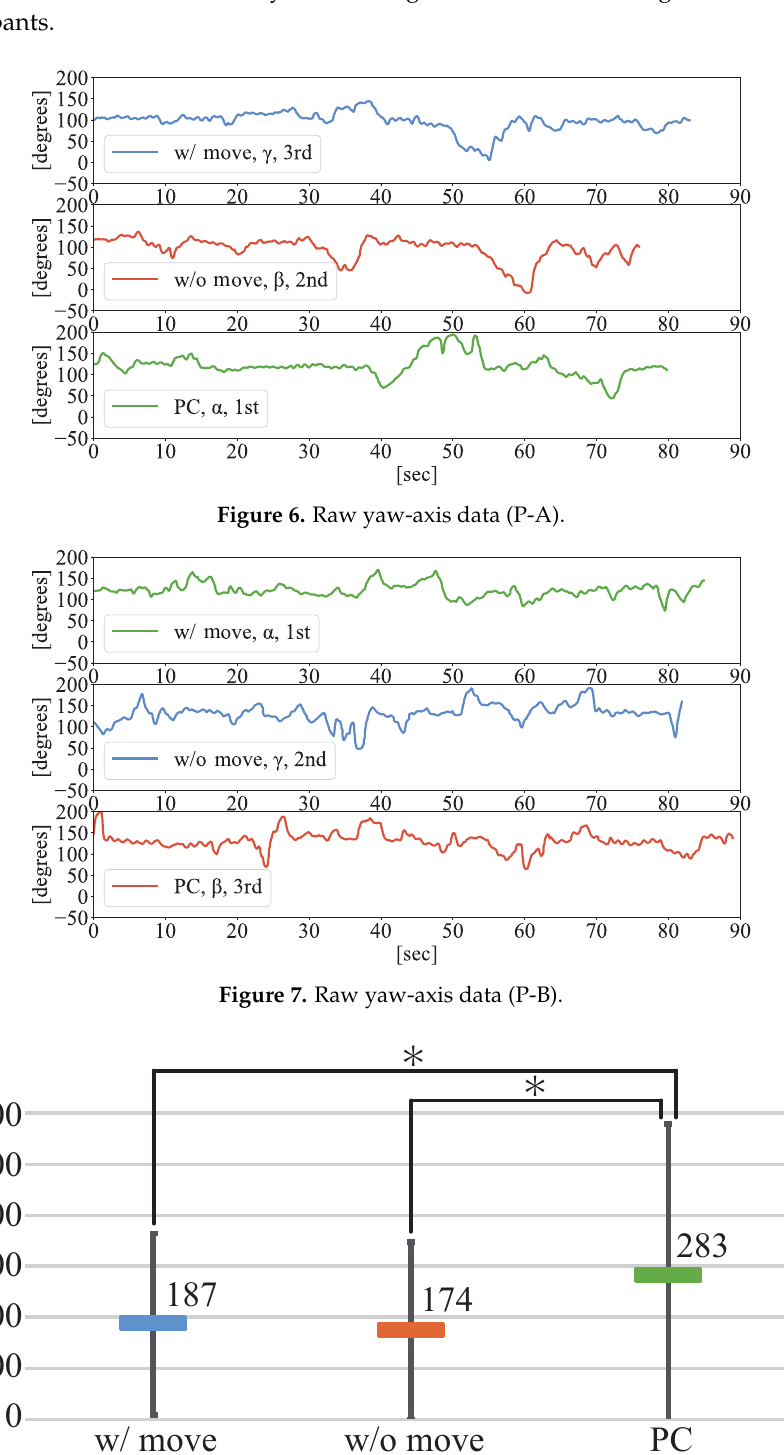
Figure 8. Average of the moving variance of yaw-axis data (shopping distinct).